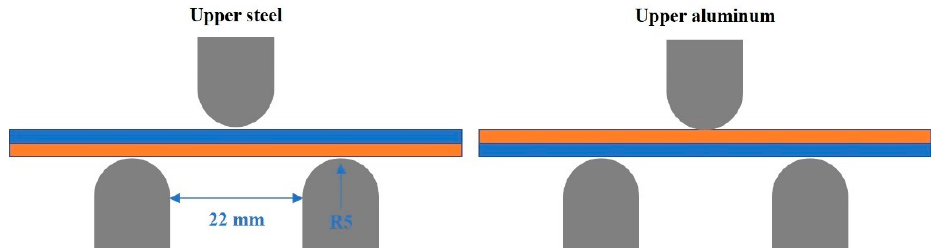
Figure 2. Shape of the bending test specimen (ASTM E290) [30].